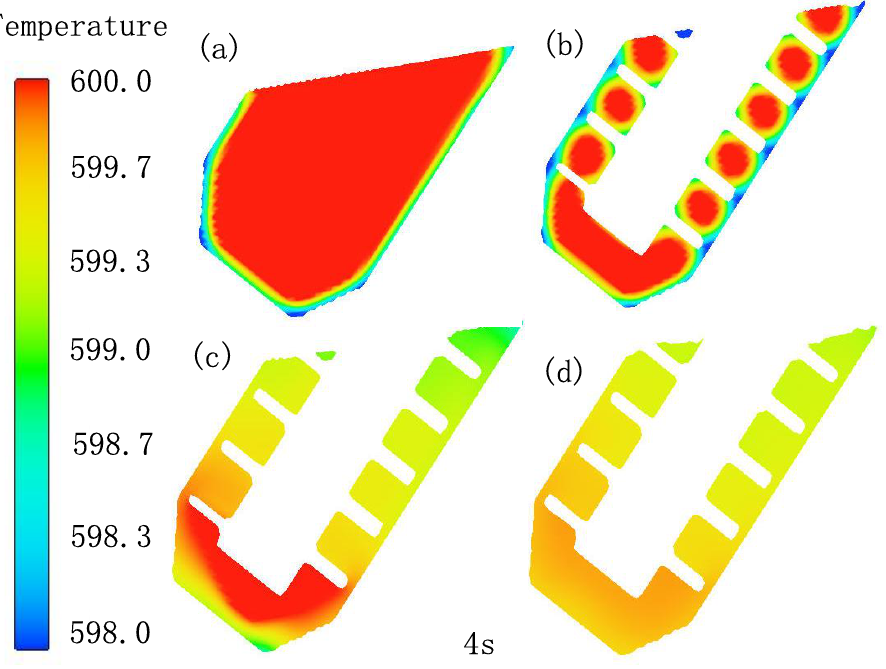
Figure 10. Temperature field simulation of the melt in FCM device at time 4 s: ( a ) without agitating shaft; ( b ) 0 r/min; ( c ) 100 r/min; ( d ) 300 r/min.